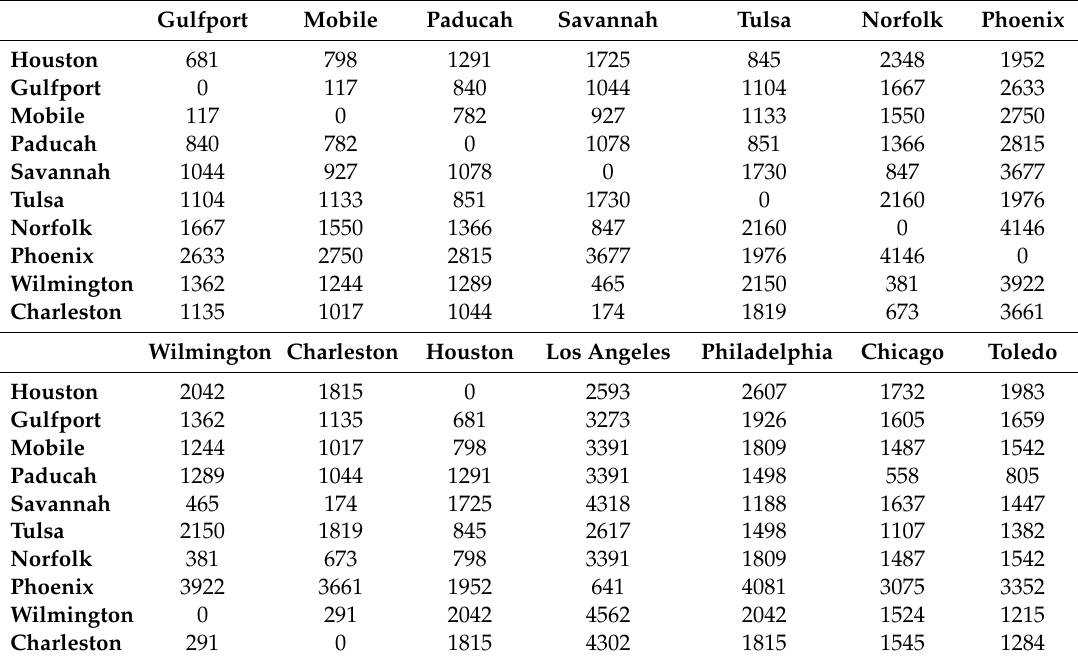
Table A6. Rail distances between Port and Extraction locations